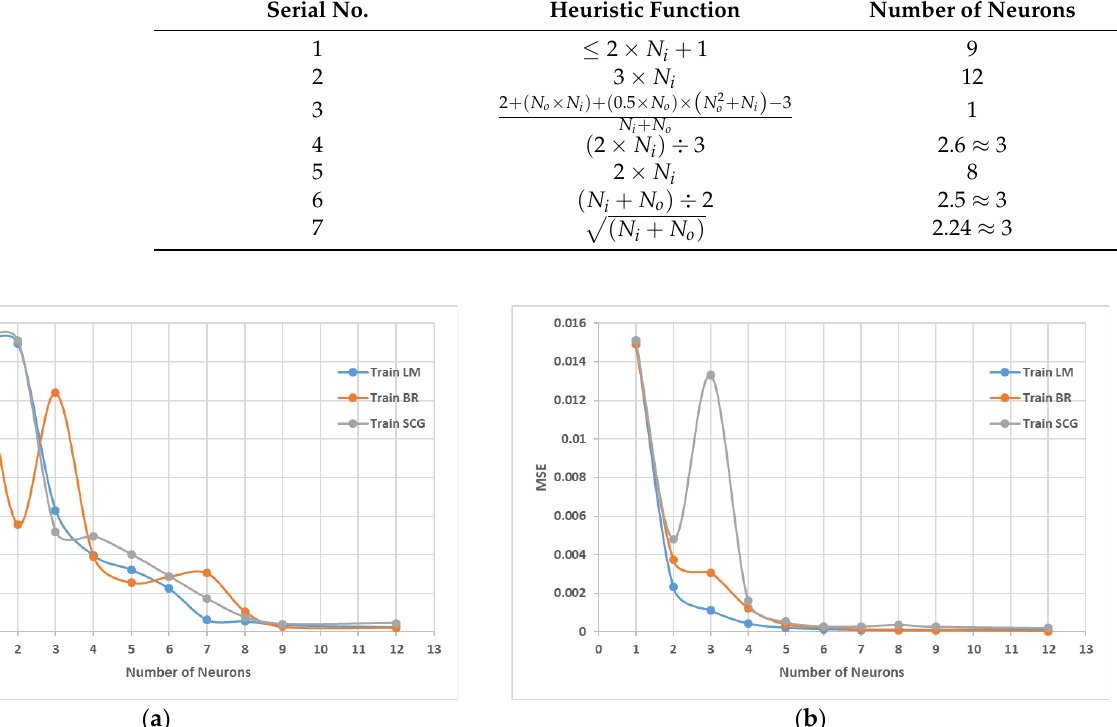
Figure 5. Accuracy test in terms of MSE of one hidden layer and two hidden layers MLA. The training and test R values for both one hidden layer (1HL) and two hidden layers (2HL) are shown in Figures 6 and 7. It should also be noted that the predicted pullout capacity values obtained from MLA needs to be validated with the experimental values. For this purpose, a 99% prediction interval was plotted. The 99% prediction interval is defined as an interval within which 99% of Y values for a certain X value will lie near the linear regression line. The upper and lower bound prediction interval values used in this study are obtained by using an established equation [102]. Figures 8 and 9 are the plots for the 99% prediction interval for both one hidden layer and two hidden layer MLAs after demoralizing and showing the actual values to be compared with the experiment. Again, it is evident that the two hidden-layer ANN predicts better than one hidden layer as all data lie within the 99% interval band. This also validates the proposed MLA model. It is clear that MLA model with TrainBR learning algorithm with two hidden layers and 12 nodes gives the most accurate predictions that fall within the 99% prediction interval.